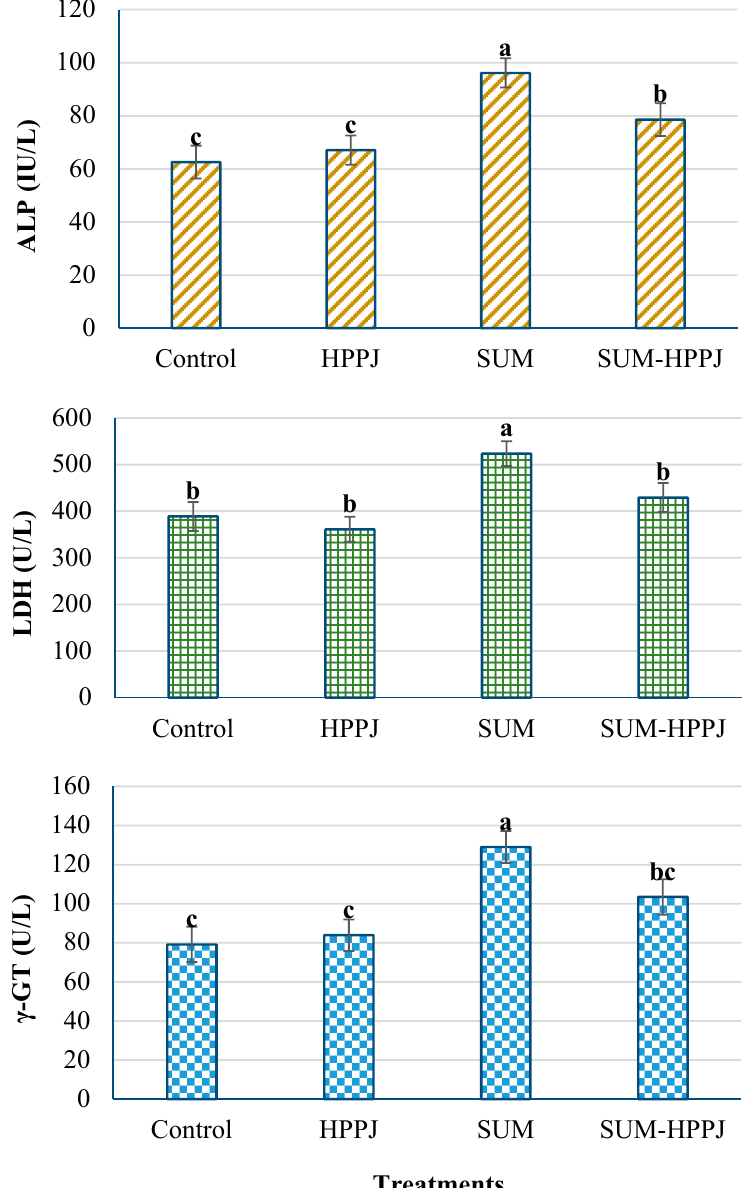
Figure 2. Mean activities of hepatic enzymes ± SE: ALP; alkaline phosphatase (IU / L), γ -GT; γ -glutamyl transferase (U / L), and LDH; lactate dehydrogenase (U / L) of white albino rats who were orally given corn oil (Control), sumithion (SUM; 85 mg / kg, 1 / 20 LD 50 ), HPPJ (a mixture of citrus bee honey, propolis, palm pollen grains, and royal jelly), and SUM-HPPJ for 28 consecutive days. Columns labeled with the same small letter were not significantly di ff erent based on Tukey’s post hoc specific comparison ( P <